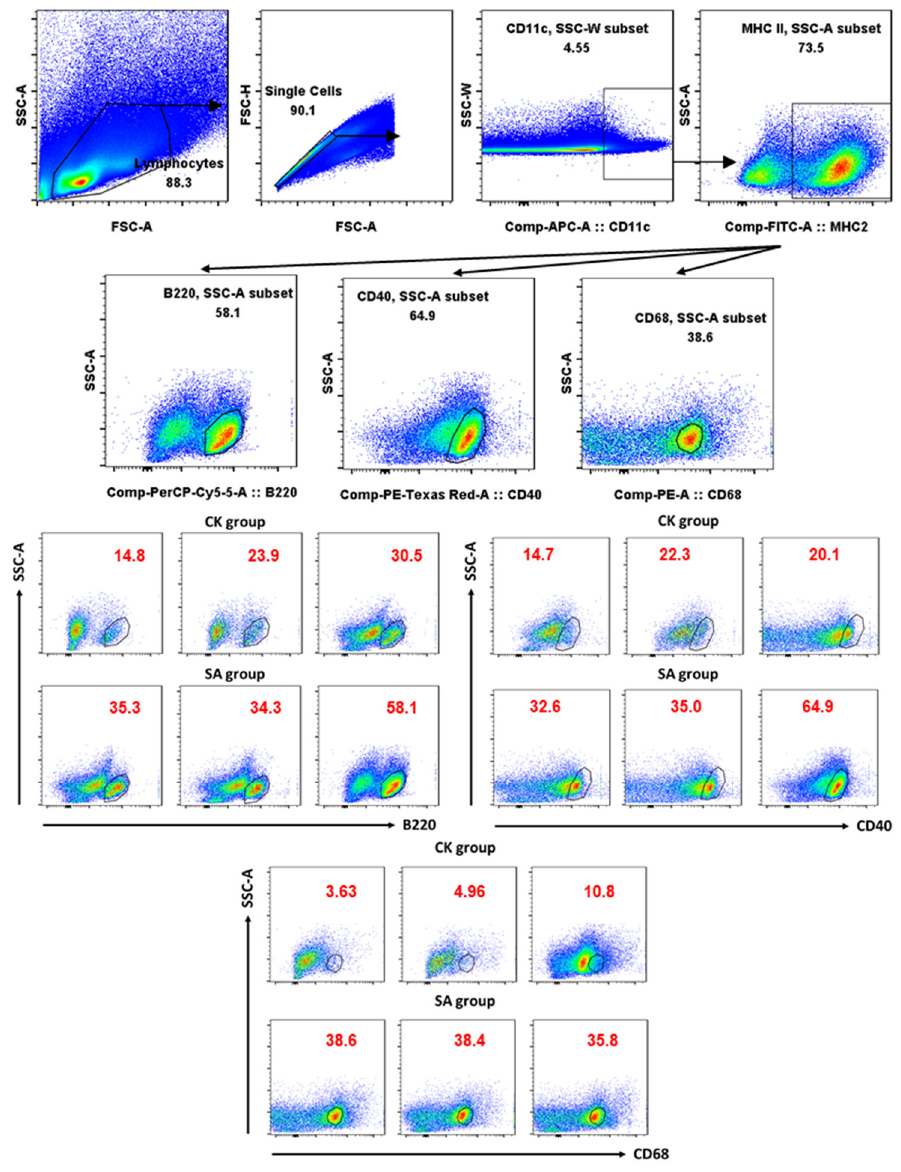
Figure 2. The percentage of B220 ( p = 0.096), CD40 ( p = 0.077) and CD68 ( p < 0.001) expressed DCs. CK, control group; SA, shrimp allergy group. Arrows represent gating logic for flow cytometry analysis. n = 3.